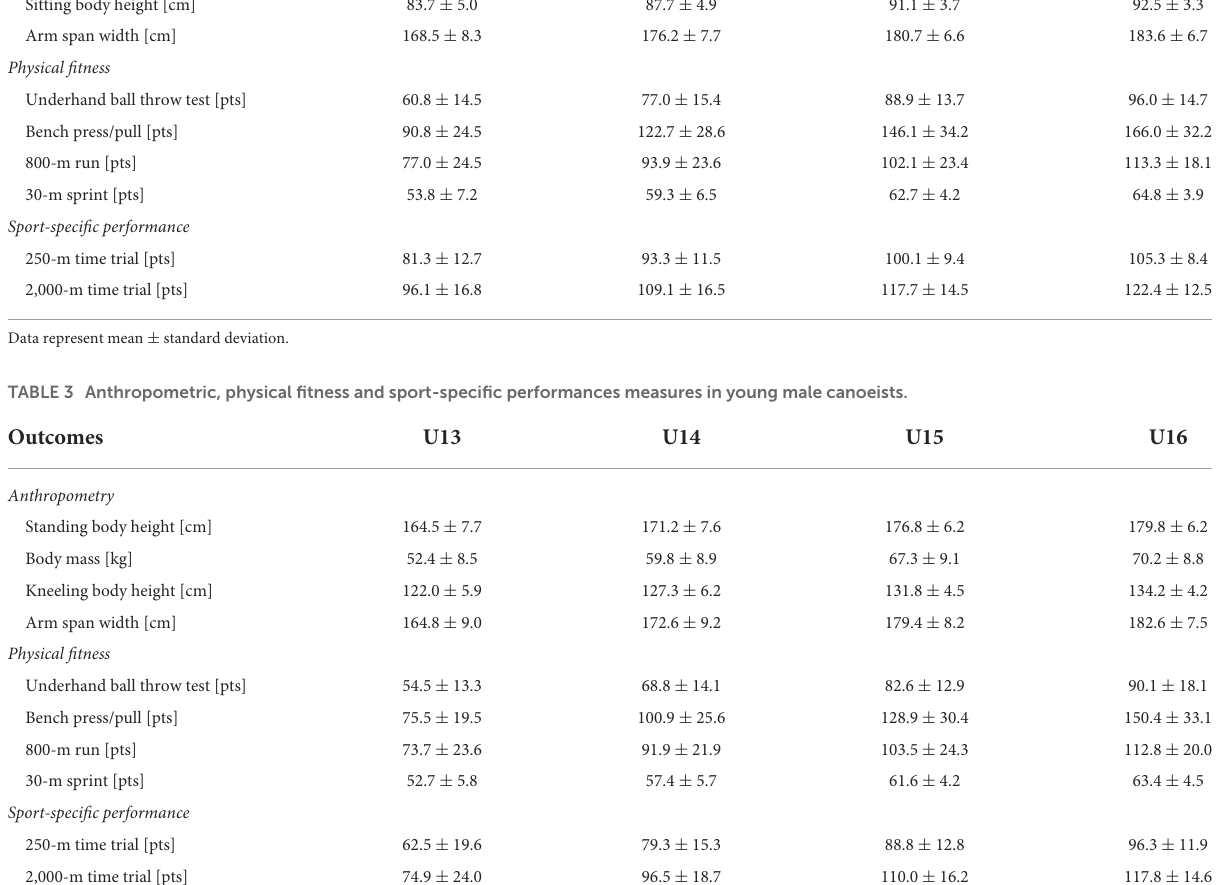
(Figure 6). When comparing the differences of µ trimmed between male and female kayakers, a significant effect was observed [F (2, 212.32) = 7.31, p < 0.01, ξ = 0.21, 95%CI (0.13, 0.32)] with significantly larger correlation coefficients in males than in